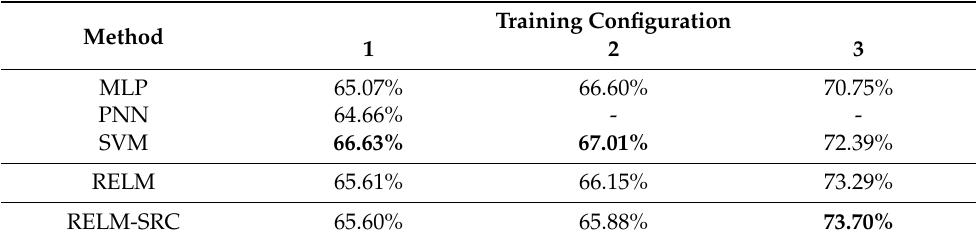
Table 6. Diagnostic accuracy P for the ProDiMES cruise testing dataset averaged for abrupt and rapid faults (Stage 1, comparison with [23]).